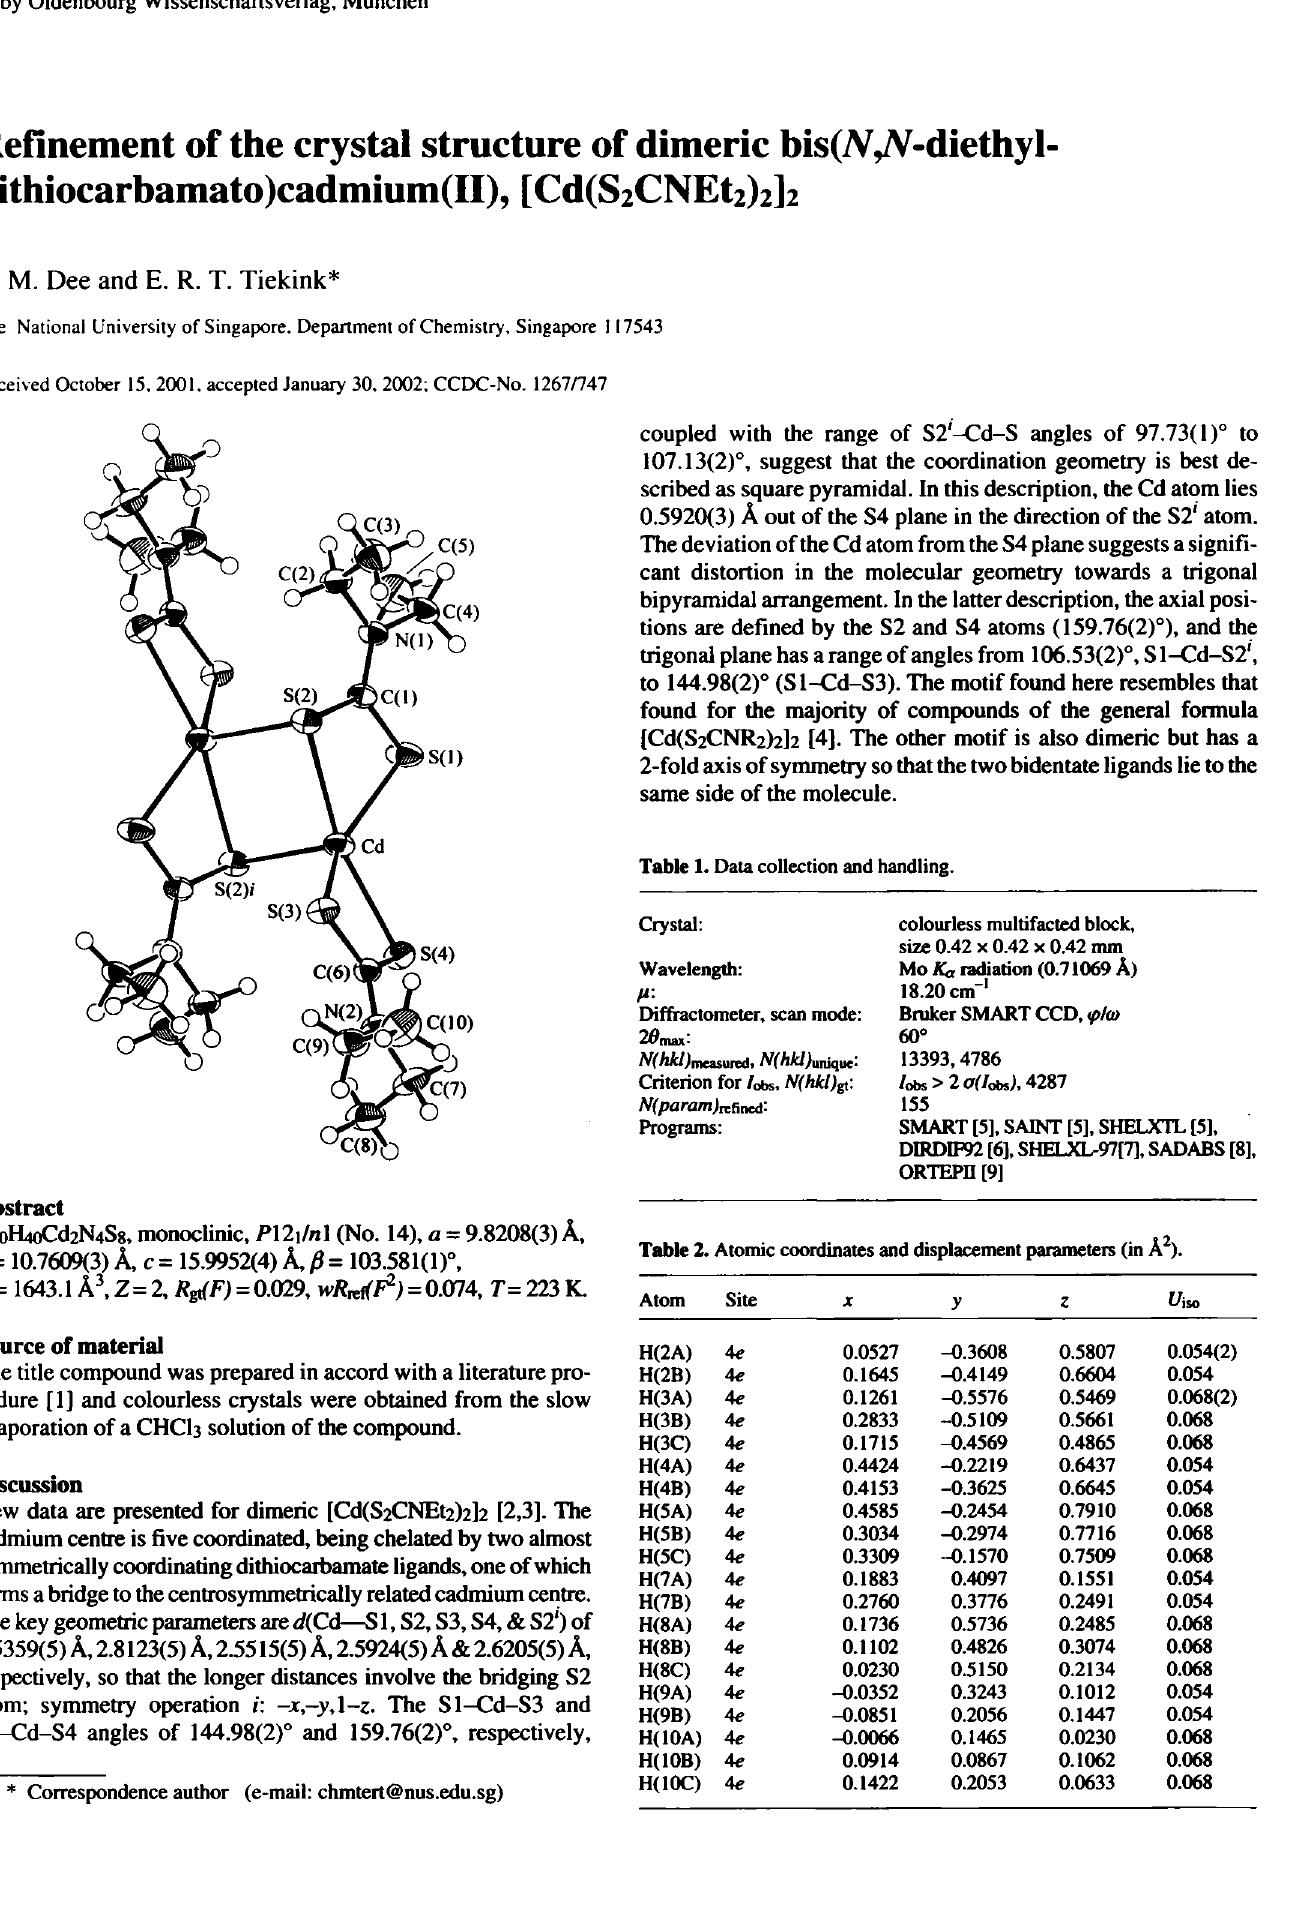
Table 2. Atomic coordinates and displacement parameters (in Â 2